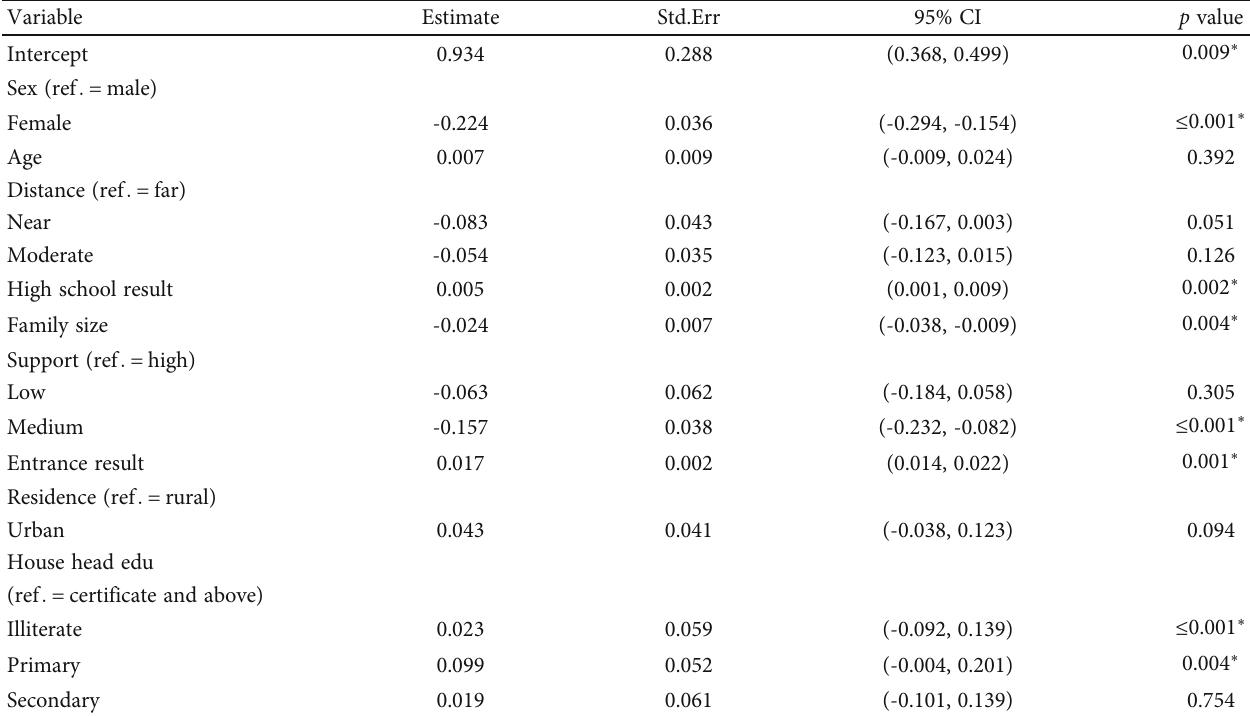
Table 2: Parameter estimates for the marginal linear-mixed e ff ect model.